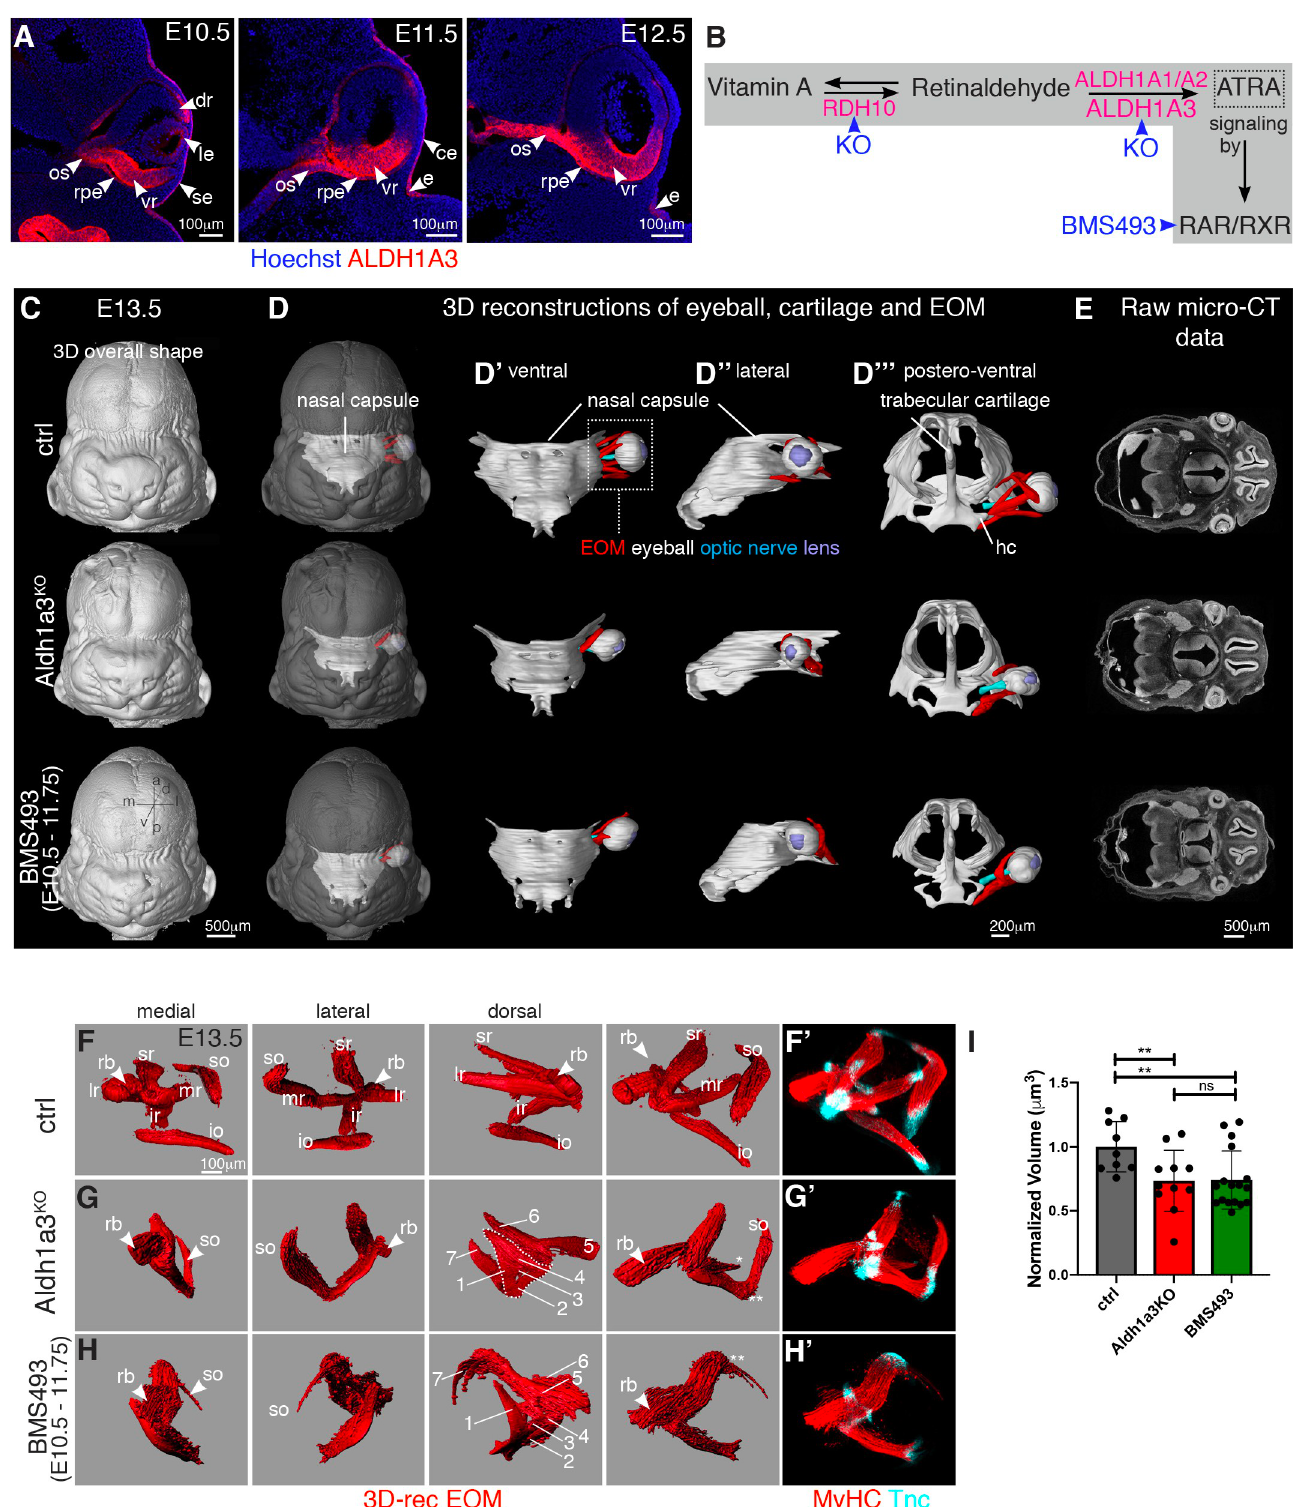
Fig 4. Extraocular muscle morphogenesis is dependent on ATRA. (A) Immunostaining for ALDH1A3 on coronal sections of E10.5, E11.5, and E12.5 control embryos ( n = 3). (B) Scheme of retinoic acid signaling pathway with key enzymes for oxidation of retinol (Vitamin A) and retinaldehyde (pink) and mutants/ inhibitors used in this study (blue). (C-D”’) Micro-CT-based 3D-reconstruction of chondrogenic mesenchymal condensations of nasal capsule, trabecular